Question: Write a caption explaining this figure to a reader.
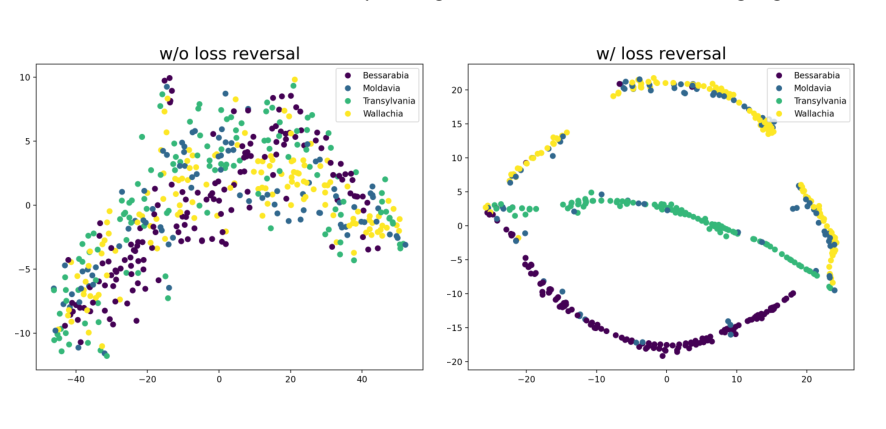
Answer: Clustering of the HistNERo test set embeddings produced by the BERT-large model using t-SNE with and without loss reversal.